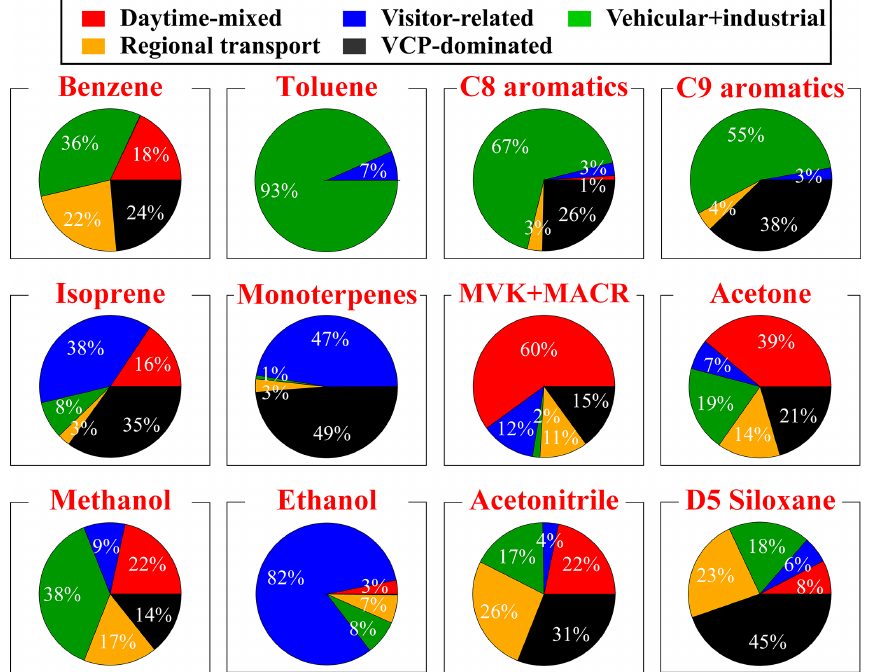
Figure 8. Average contribution percentages of the five PMF factors to concentrations of the nine selected VOC species during the CTT